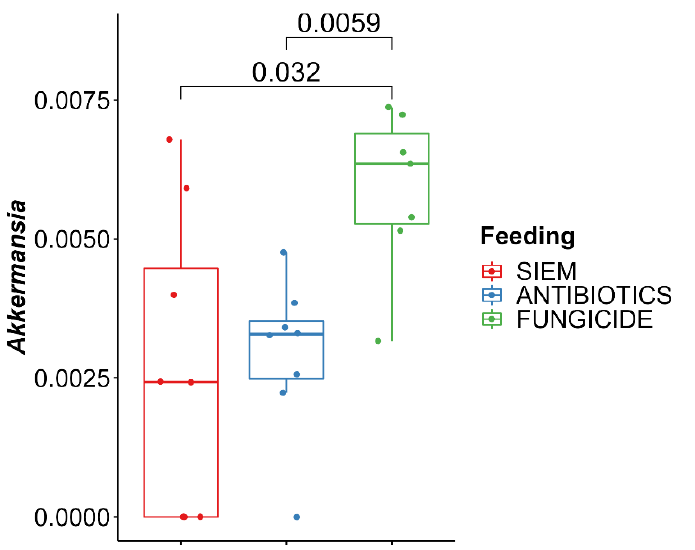
Figure 6. Kruskal–Wallis with Dunn’s post-hoc pairwise comparison for Akkermansia .